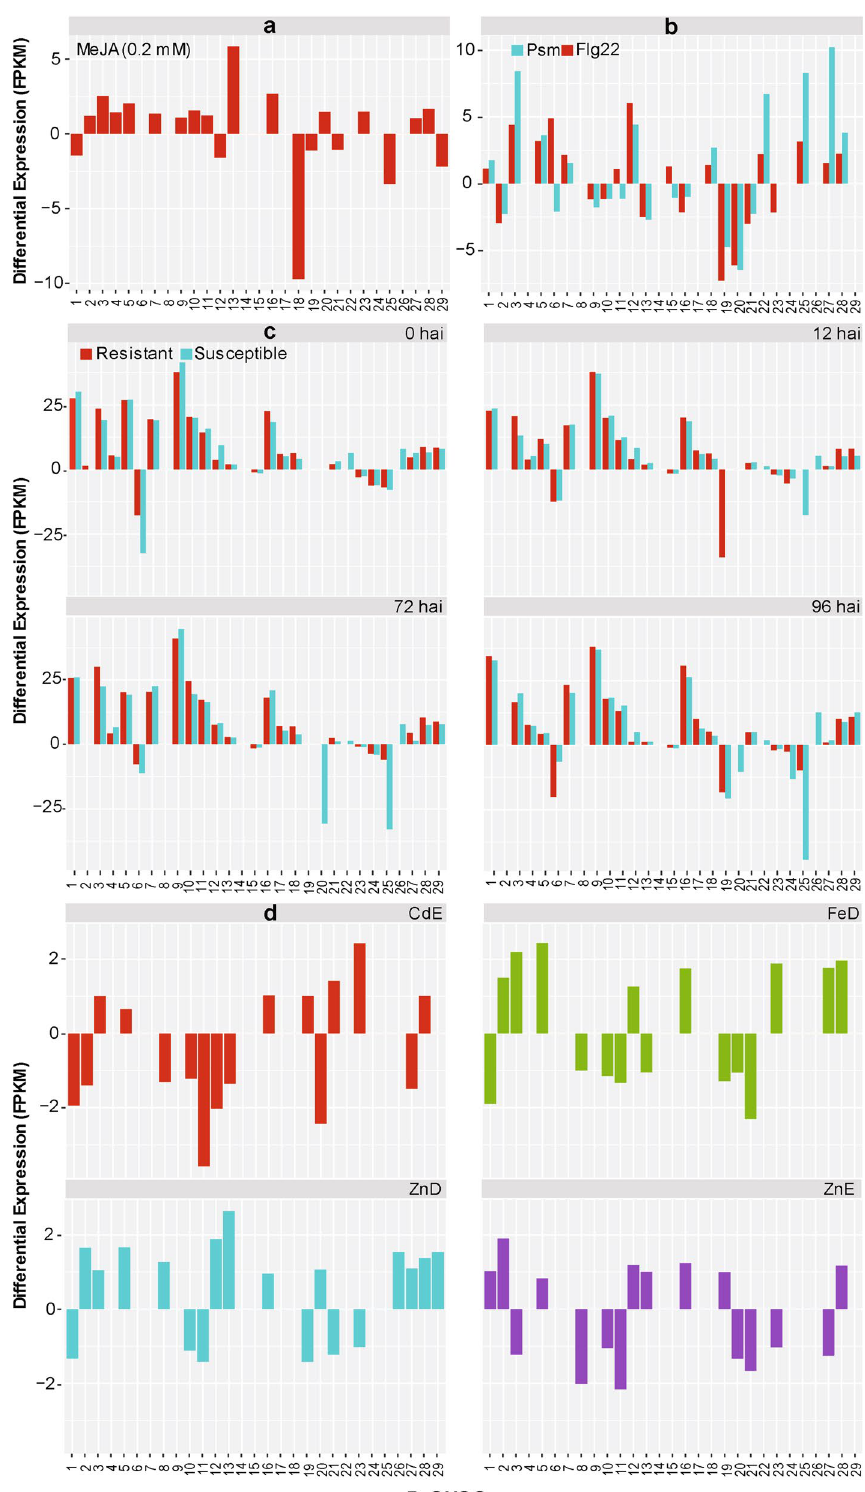
Figure 6. Dynamic expression profiles of BrCNGC genes in Brassica rapa L. plants, subjected to different stress types. ( a ) Exogenous hormone (0.2 mM of MeJA). ( b ) Bacterial pathogen ( Psm ) and elicitor flagellin (Flg22). ( c ) P. brassicae in clubroot resistant and susceptible Cabbage lines at 0, 12 72 and 96 h after inoculation. ( d ) Trace element stress represented by cadmium excess (CdE), iron deficiency (FeD), zinc excess (ZnE) and deficiency (ZnD), respectively. The final relative expression level of each transcript shown in this figure is calculated as fold change compared to controls/mocks, where threshold > 0 indicate up-regulation and threshold < 0 show down-